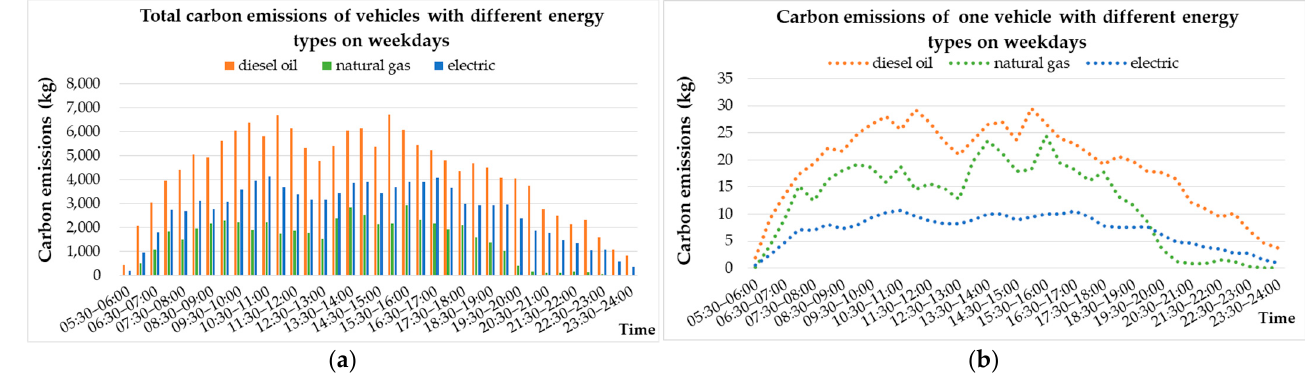
Figure 6. Time distribution of different types of energy type buses’ carbon emissions in Sanya on weekdays. ( a ) Total carbon emissions of vehicles with different energy types on weekdays. ( b ) Carbon emissions of one vehicle with different energy types on weekdays.